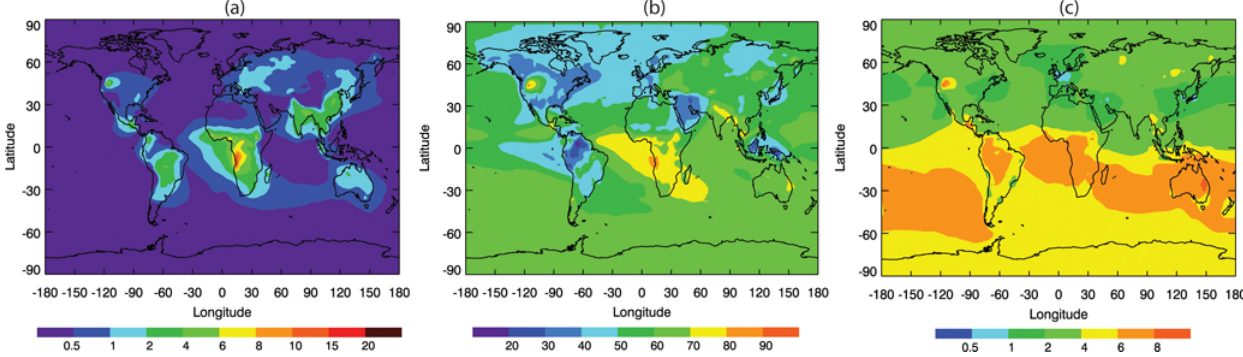
Fig. 1. The estimated (a) annual mean atmospheric burden (mgm 2 ) of BrC, (b) percentage (%) of BrC in total OC, and (c) ratio of BrC to BC. Table 2. The imaginary refractive index, absorption cross section, and absorption Ångström exponent (AAE) calculated for brown carbon (BrC) at various wavelengths, compared with those from Chen and Bond (2010) and Kirchstetter et al. (2004). Imaginary refractive index Absorption cross section at indicated AAE at indicated wavelength wavelength (m 2 g − 1 ) Wavelength λ (nm) 350 450 550 650 350 450 550 650 400–700 Moderately absorbing BrC 0.075 0.02 0.003 Strongly absorbing BrC 0.168 0.063 Chen and Bond (2010) ∗ 0.1 Kirchstetter et al. (2004) 0.168 ∗ The absorption cross sections shown are for methanol-soluble OAK_L_360 in Chen and Bond (2010); refractive index is derived based on ρλσ /4 π , where ρ is the density of BrC, 1.65gcm − 3